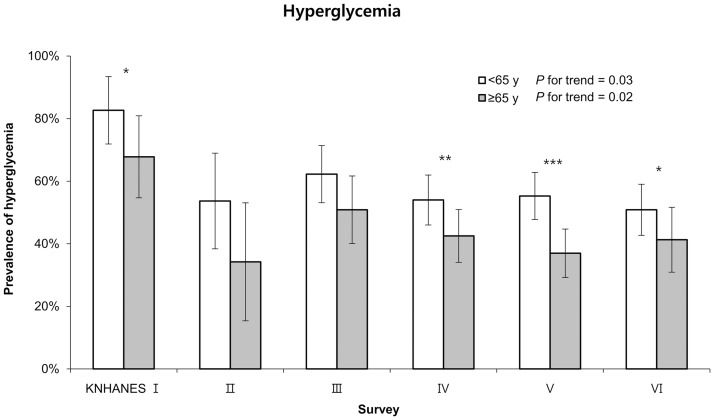
The prevalences of hyperglycemia among patients with diabetes mellitus according to age group and survey period.Values are adjusted for sex, medication use, smoking status (current smoker, previous smoker, or never smoker), alcohol consumption (<1 vs. ≥1 drink/day for women or <2 vs. ≥2 drinks/day for men), body mass index (<23 kg/m2 or ≥23 kg/m2), education level (less than high school or more than high school), duration of diabetes, and psychosocial stress. *p < 0.05, **p < 0.01, ***p < 0.001.